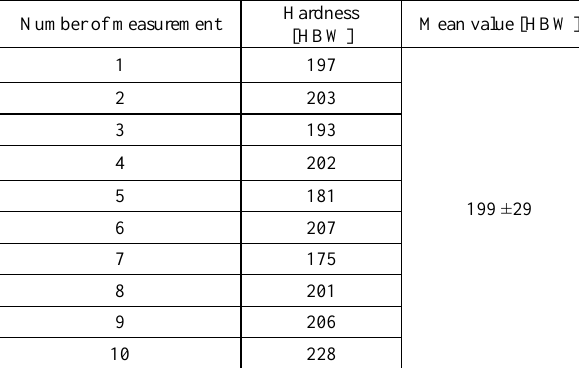
Table 2. Results of Brinell hardness tests